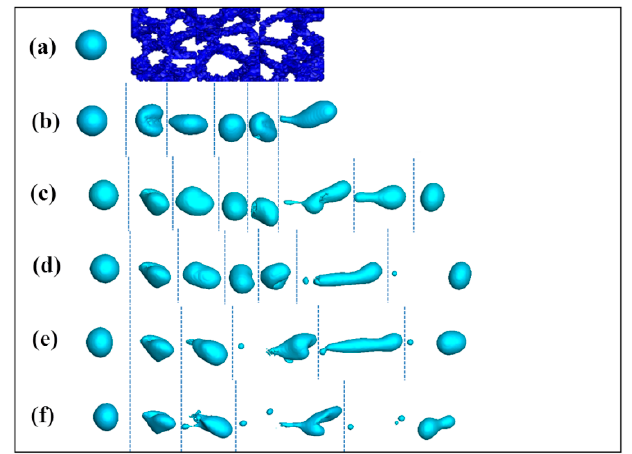
Figure 5. Hydrodynamics of one droplet passing a metal foam with di ff erent Ca values ( L d = 7.32, D d = 1.82): ( a ) schematic diagram, ( b ) Ca = 0.031, ( c ) Ca = 0.046, ( d ) Ca = 0.061, ( e ) Ca = 0.078, and ( f ) Ca = 0.092.